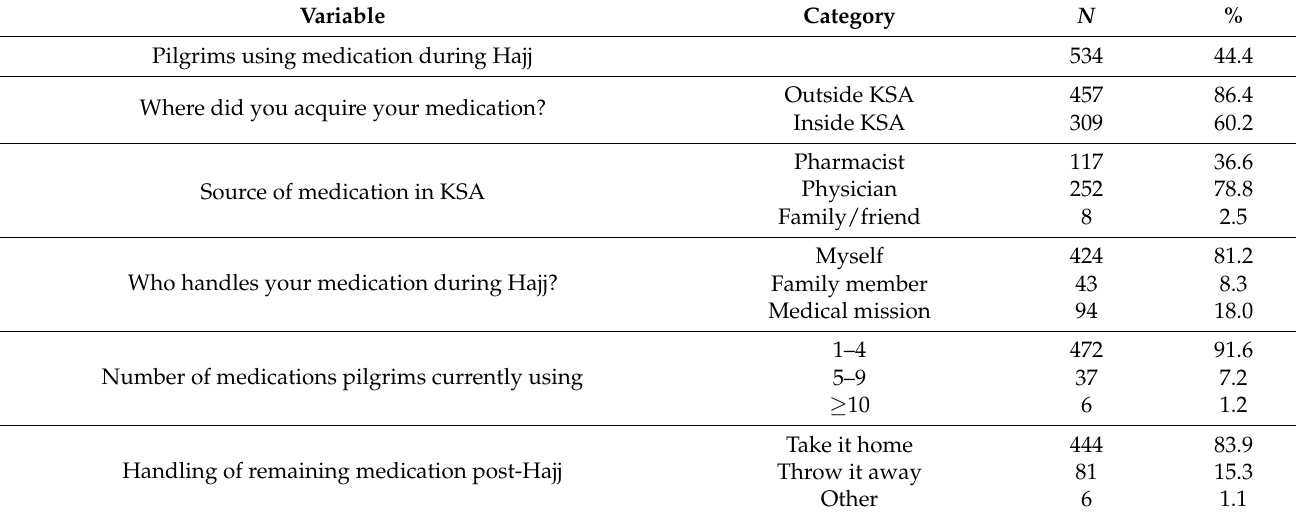
Table 3. Medication sources and handling during the Hajj pilgrimage.